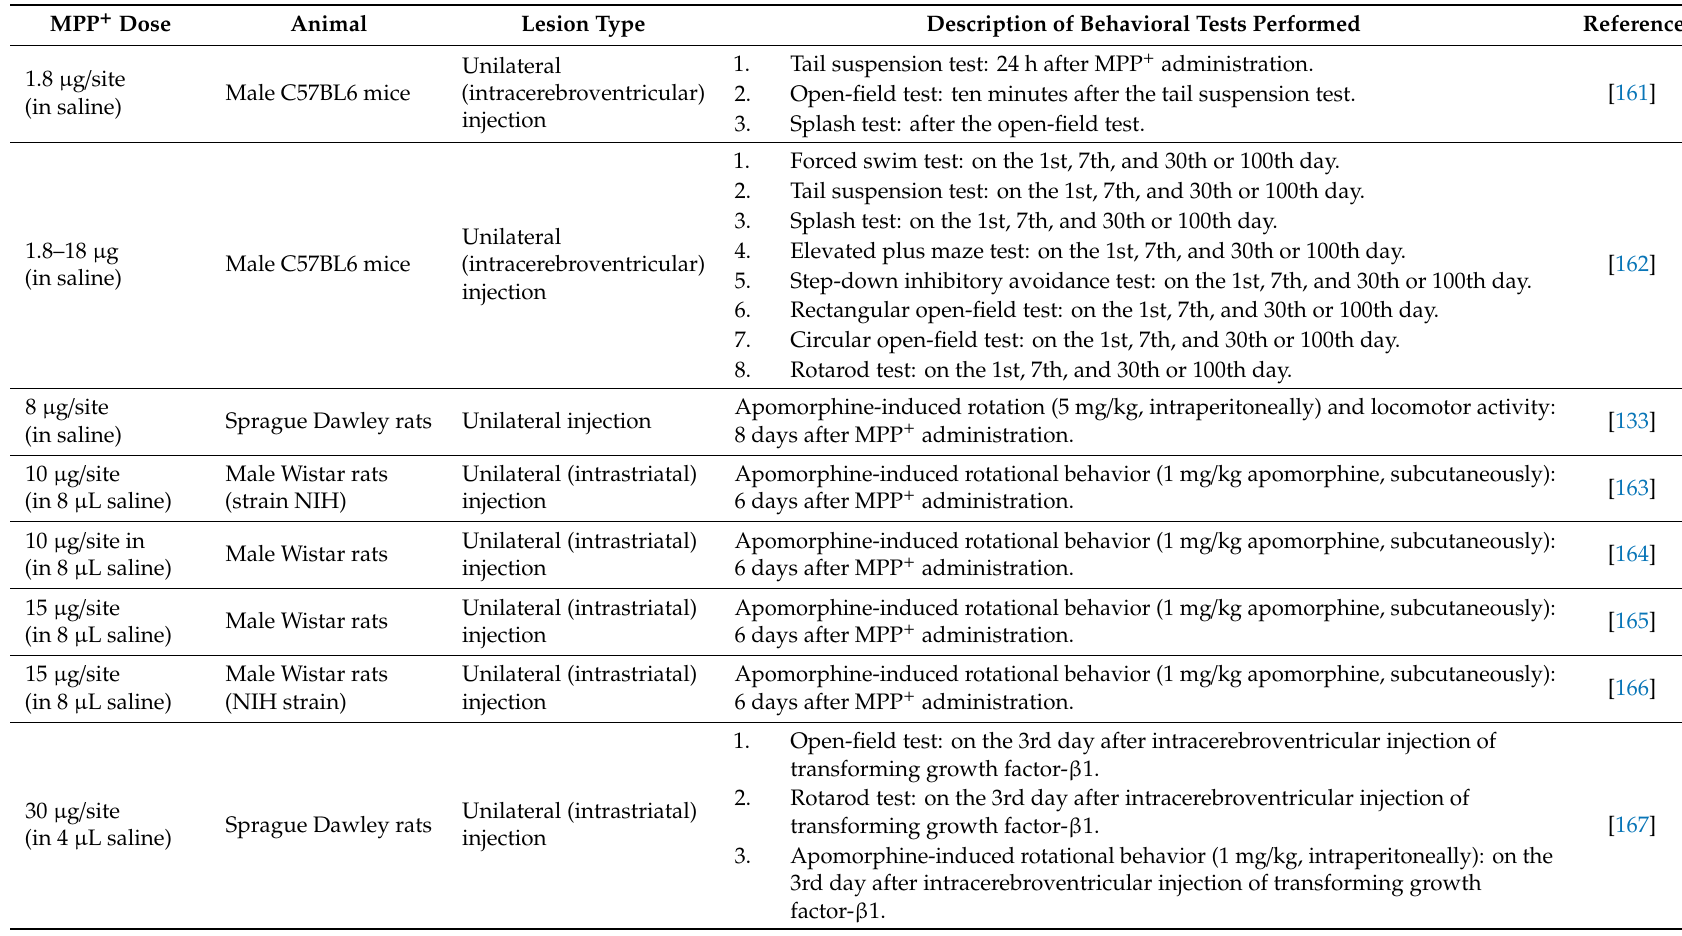
Table 4. The dose, lesion type and behavioral evaluating methods in each MPP + -induced PD animal